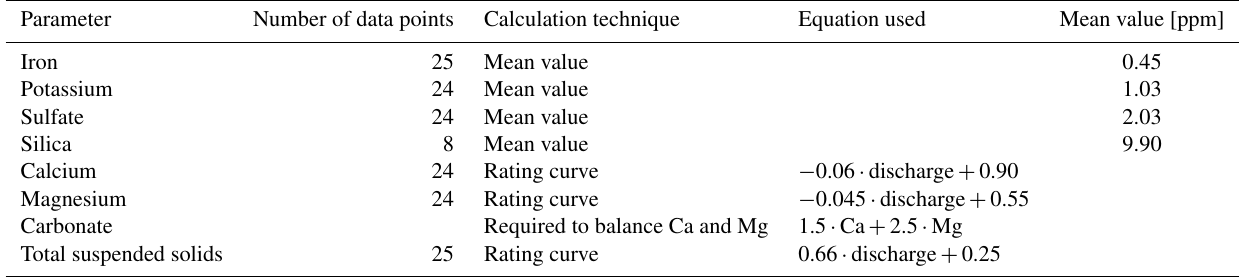
Table 6. Water quality data for the George River at St.